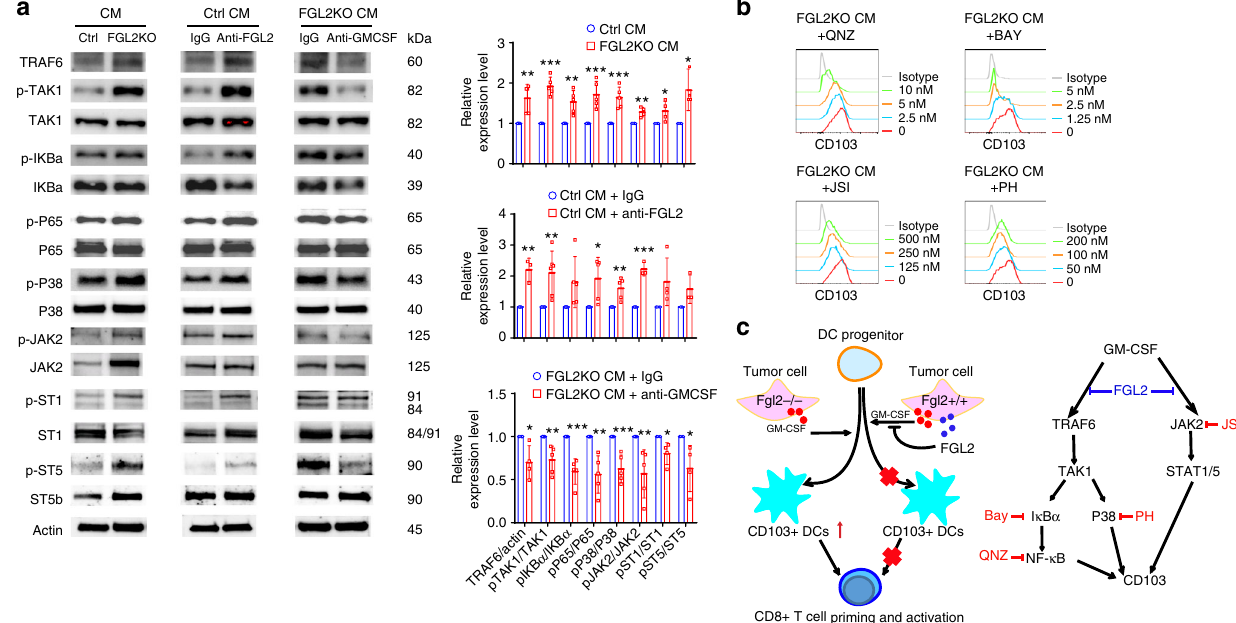
Fig. 6 FGL2 suppresses NF- κ Bp65 and STAT1/5 signaling for CD103 induction. a , Expression levels of key proteins in the TAK1-NF- κ B/p38 cascades and JAK2/STAT1/5 signaling were examined by western blotting in bone marrow cells cultured with conditioned medium (CM) from control tumor cells ( Ctrl ), FGL2KO tumor cells, Ctrl- CM + IgG, Ctrl -CM + anti-FGL2, FGL2KO -CM + IgG, or FGL2KO -CM + anti-GM-CSF for 3 days. Data were summarized as ratio changes from at least three independent experiments. The t -test was used to calculate the two-sided P values. Signi fi cant results were presented as * P < 0.05, ** P < 0.01, *** P < 0.001. b Representative FACS analysis of CD103 expression on CD11c + B220 - dendritic cells (DCs), which were pretreated for 1 h with I κ B α inhibitor Bay 11-7085 (Bay), NF- κ B inhibitor 6-amino-4-(4-phenoxyphenylethylamino) quinazoline (QNZ), JAK2 inhibitor JSI-124 (JSI), or p38 inhibitor PH797804 (PH) in bone marrow cells cultured with CM for 5 days. Plots are representative of three independent experiments. c Schematic illustration of cellular and molecular events underlying FGL2-regulated GBM progression. Tumor cells secreted GM-CSF and FGL2 simultaneously. GM- CSF-induced CD103 + DCs development was blocked in the presence of FGL2, so that CD8 + T cells were not primed and activated because of